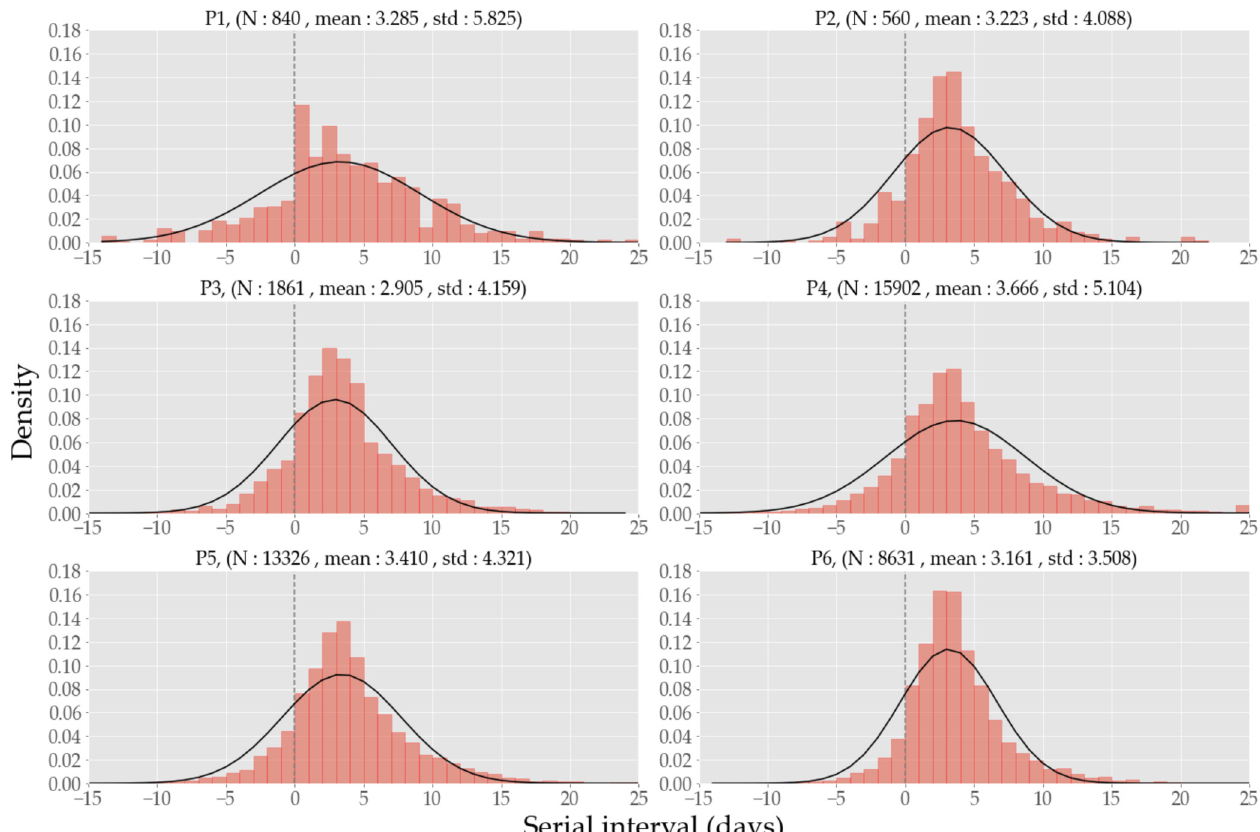
Figure 4. The serial interval distribution and its normal distribution fit in each